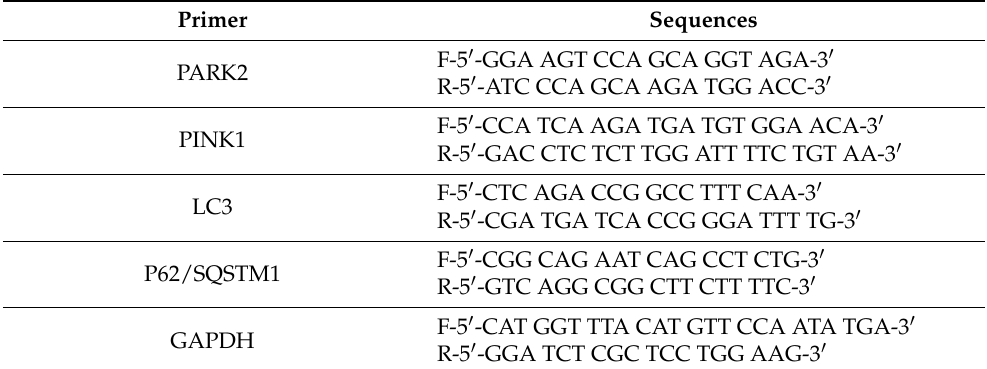
Table 1. Primer sequences used for RTqPCR